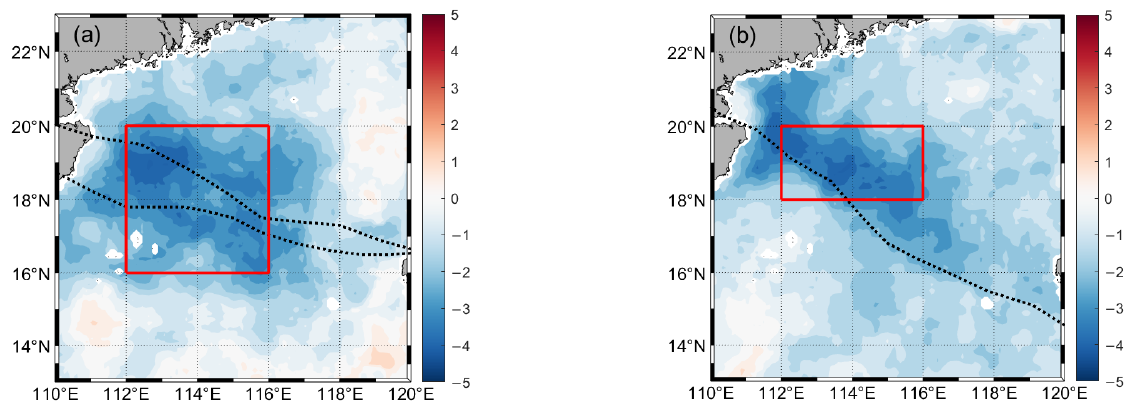
Figure 11. SST responses to successive typhoons ( a ) and Rammasun ( b ). The red box indicates the main cooling area caused by the typhoon.